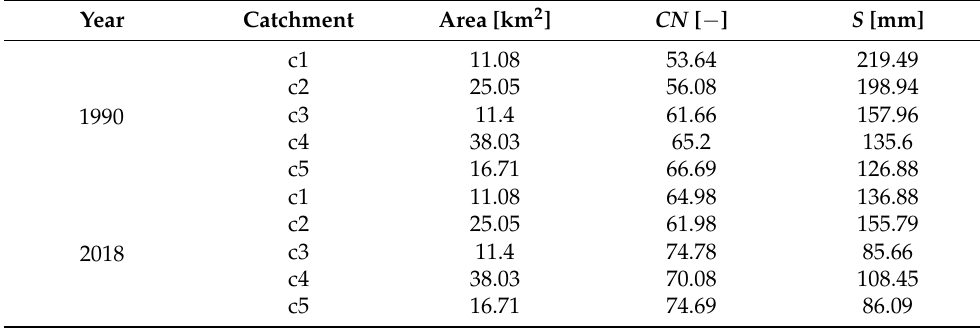
Table 1. Values of CN and S parameters in sub-catchments for two years (1990 and 2018).